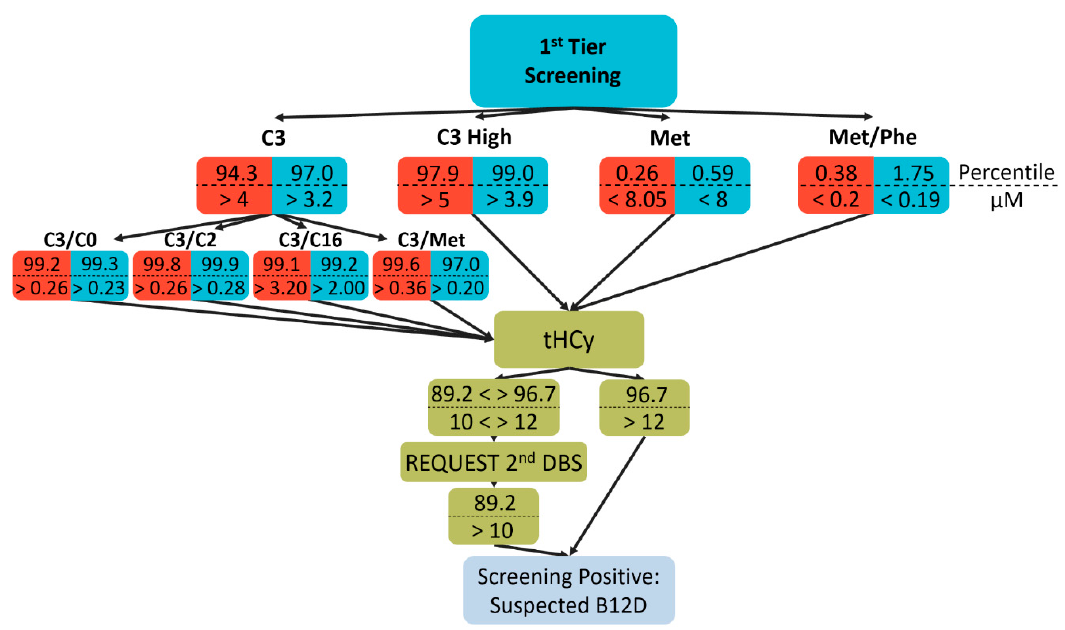
Figure 1. Screening decision algorithm for suspected vitamin B12 deficiency (B12D). Samples for total homocysteine (tHCy) measurement were selected by markedly elevated propionylcarnitine (C3 high) and in case of moderate elevation an additional elevation of one of the C3 ratios to, free carnitine (C0), acetylcarnitine (C2), palmitoylcarnitine (C16), and methionine (Met). Alternatively, lowered Met or its ratio to phenylalanine (Phe) leads to selection for tHCy measurement. Newborns were suspected for B12D if tHCY values were over 12 µM. tHCY measurement was repeated in a second dried blood spot if the primary value was between 10 µM and 12 µM. If the second measurement was also above 10 µM the newborn was categorized as screening positive. The values in the red and blue fields give percentiles (top) and absolute values (in µM, bottom) of used cutoff values for the first and second period, respectively. C3, propionylcarnitine; C3/C0, propionylcarnitine to free carnitine ratio; C3/C2, propionylcarnitine to acetylcarnitine ratio; C3/C16, propionylcarnitine to palmitoylcarnitine ratio; C3/Met, propionylcarnitine to methionine ratio; Met, methionine; Met/Phe, methionine to phenylalanine ratio.